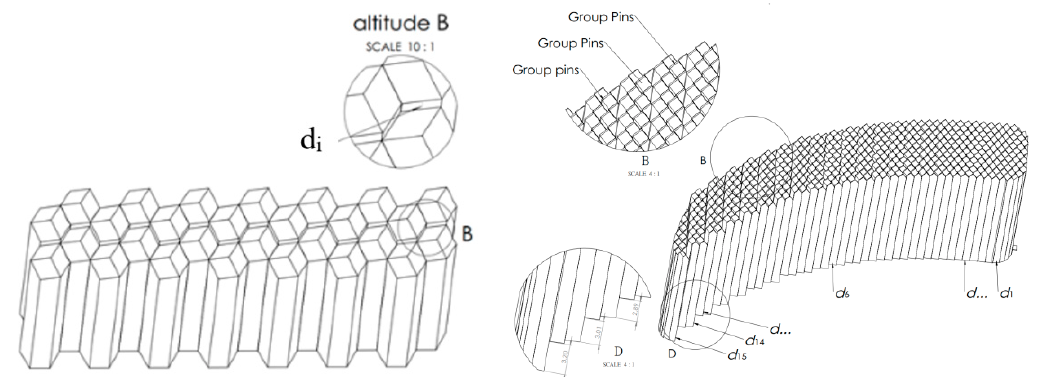
Figure 18. Height difference d i between neighboring pins in a double-pin